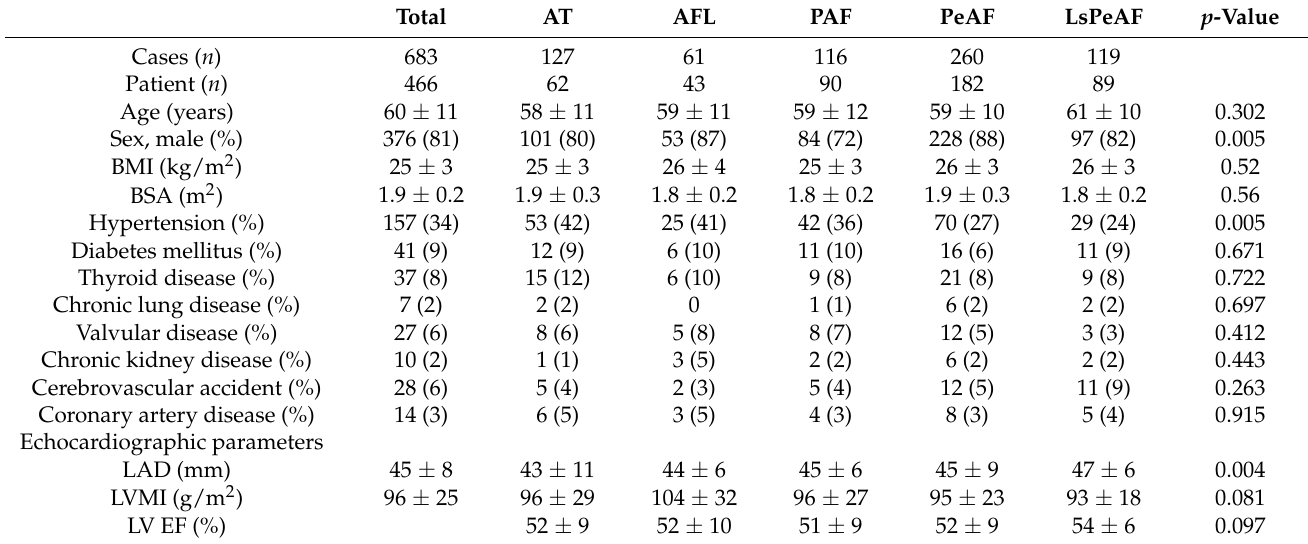
Table 1. Baseline characteristics of the study population based on the type of arrhythmia. Total AT